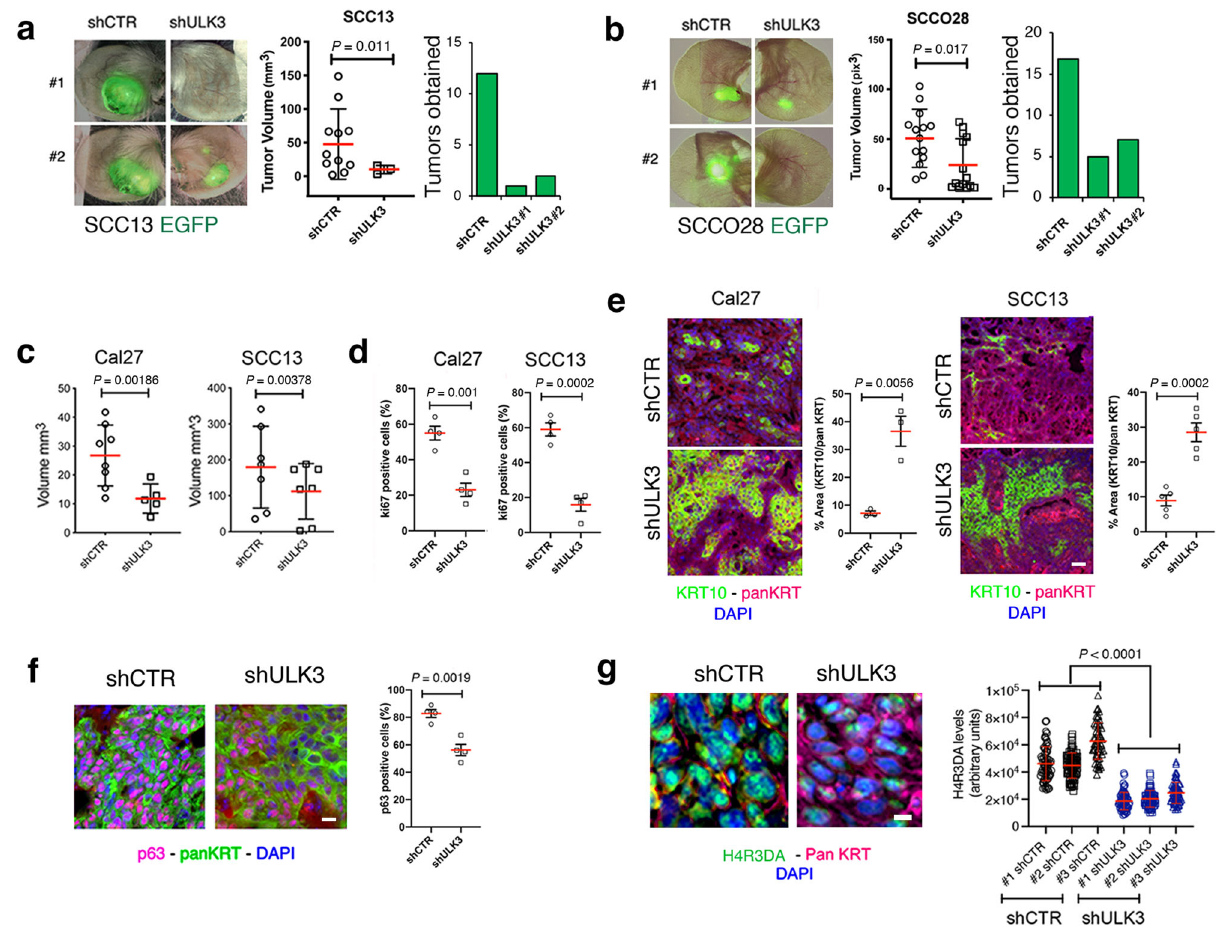
Fig. 9 | ULK3 downregulation suppresses SCC growth in vivo. a, b Ear injection skin SCC model. SCC13 ( a ) and SCCO28 ( b ) cells expressing an enhanced green fl uorescence protein (EGFP) were infected with two ULK3 -silencing or control lentiviruses. Mice (NOD/SCID-Prkdc scid ; CB-17) received contralateral ear injections of either ULK3- or control - silenced cells. Representative fl uorescence with